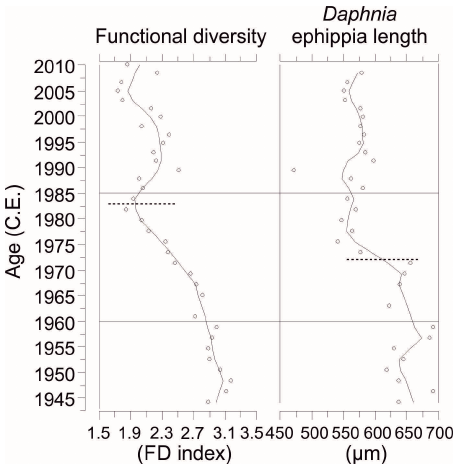
Figure 6. Cladoceran functional diversity (FD) and mean Daphnia ephippia length in the Lake Maggiore sediment core. The horizontal lines define the reference (pre-1960), eutrophication (1960–1985), and recovery (post-1985) periods, and the dashed horizontal lines represent segmented regression breakpoints.